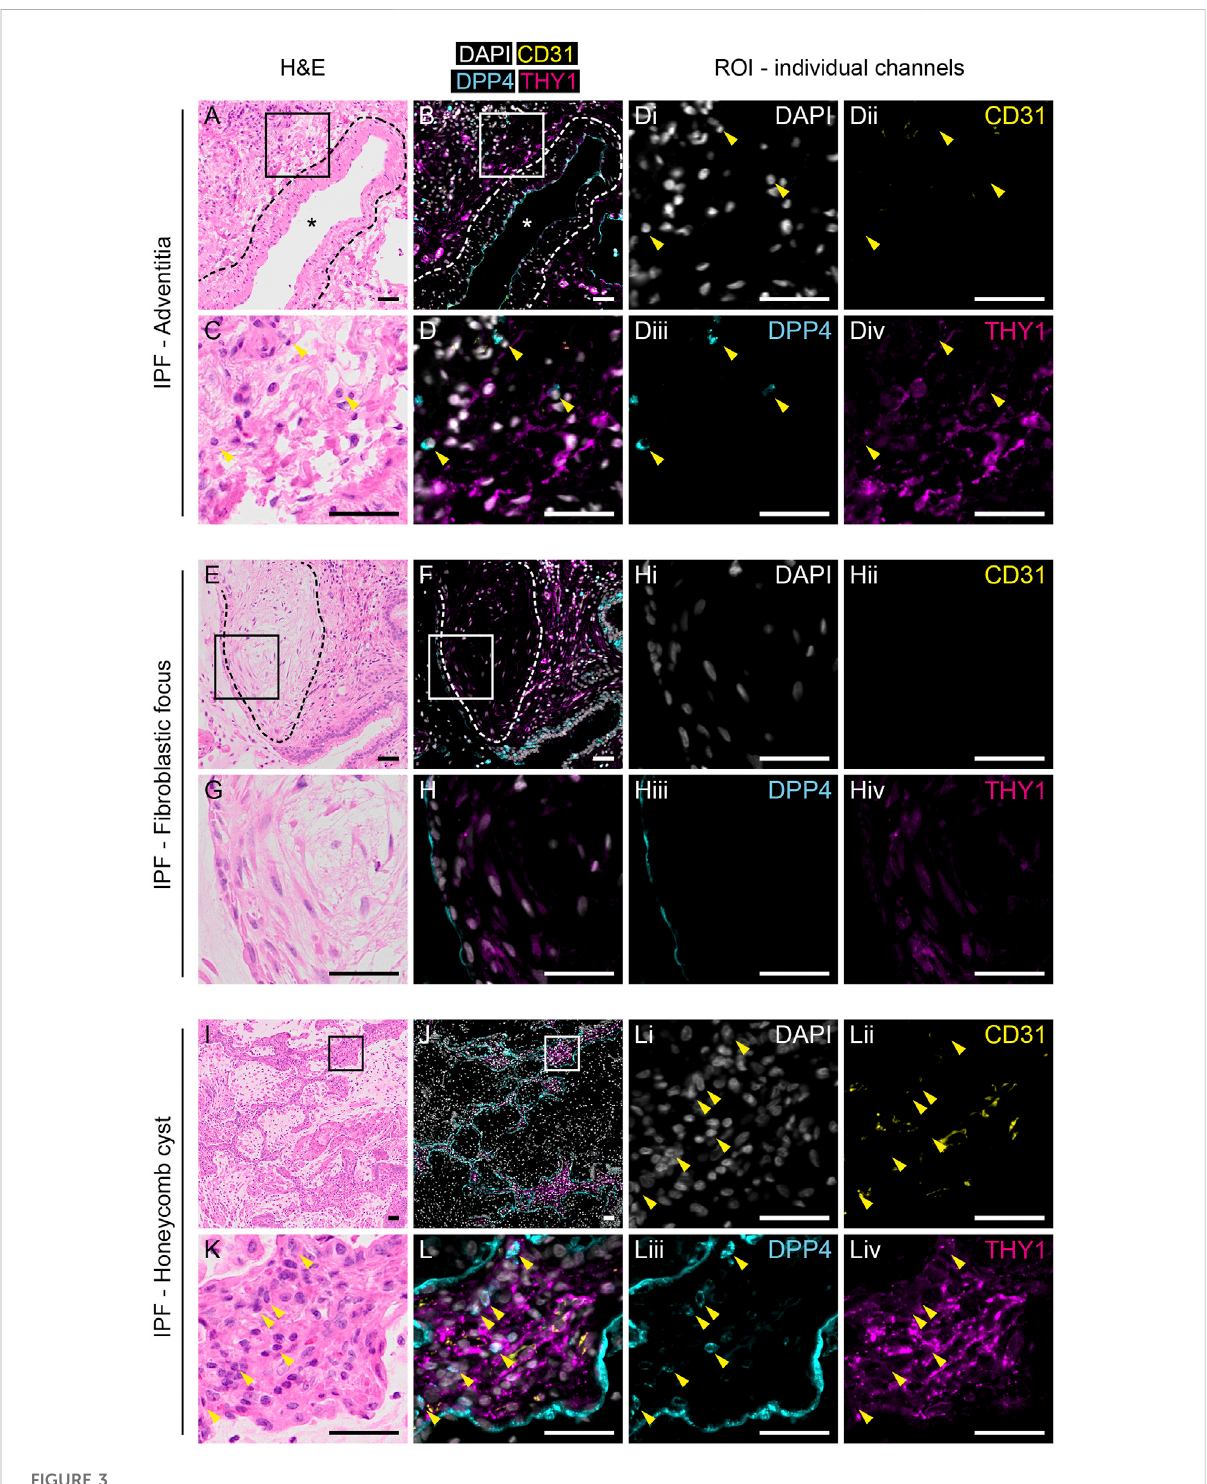
FIGURE 3 Expression ofTHY1andDPP4inIPFtissue.H&E(leftpanels)andimmuno fl uorescencestainingfor DAPI(white),CD31 (yellow), DPP4(cyan)and THY1 (magenta, middle and right panels) in tunica adventitia (A – D) , fi brotic focus (E – H) and honeycomb cysts (I – L) from IPF lung tissue. Regions of interest (ROI) marked byrectangles (150 µm× 150 µm) in (A) , (B) , (E) , (F) , (I) and (J) are enlarged in (C) , (D) , (G) , (H) , (K) and (L) , respectively. Individual channels with DAPI (i), CD31 (ii), DPP4 (iii) and THY1 (iv) from (D) , (H) and (L) are shown (third and fourth column). Arrowheads indicate CD31- THY1 − DPP4 + cellslocalizedtoregionsofCD31-THY1 + DPP4 - cells.Bloodvesselsareindicatedwithanasterisk(*).Dashedlinesin (A) and (B) highlight the border between tunica media and tunica adventitia. Dashed lines in (E,F) encircle a fi broblastic focus. Scale bars represent 50